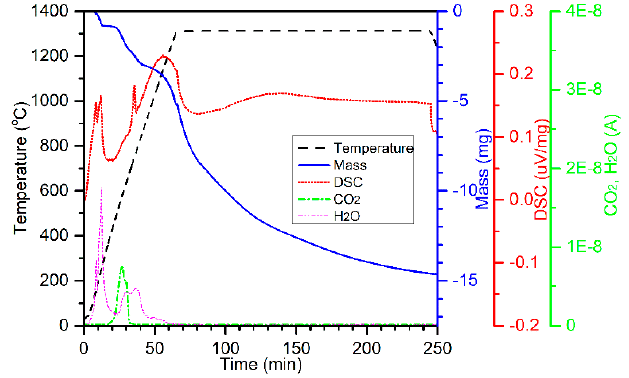
Figure 13. TG-DSC-MS test on the interaction between the chromite ore and CaCl 2 .